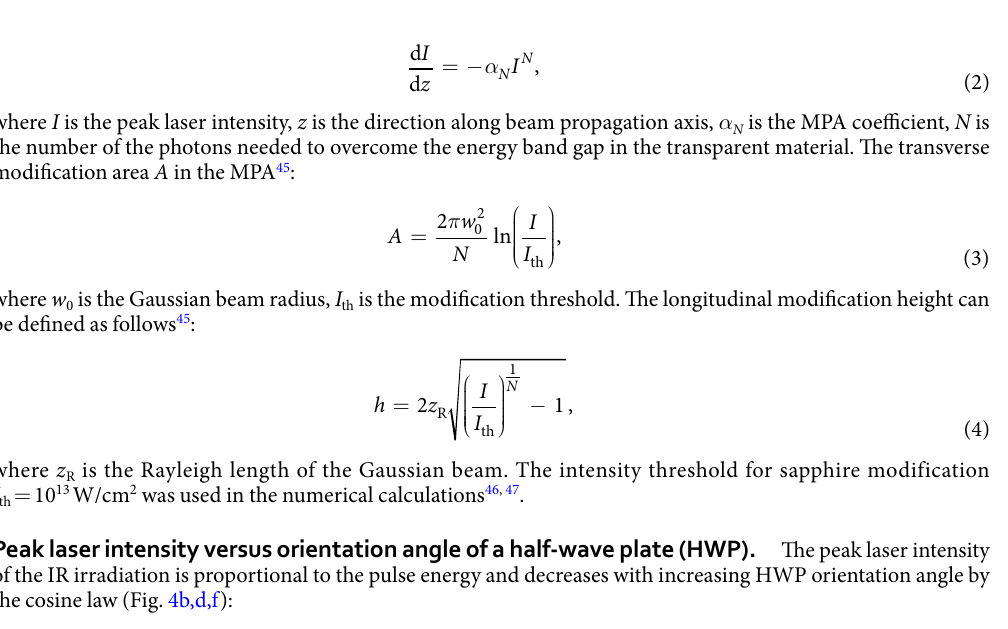
where ϕ - is the angle of HWP orientation with the reference (zero) orientation angle, corresponding to the whole energy directed to the IR optical beam path, E ° 1064 = 20 μ J and E 0 1064 = 68 μ J - is the maximum pulse energy of the fundamental harmonics of the first and second laser sources, respectively. The peak laser intensity of UV irradi- ation is proportional to the pulse energy and increases with the orientation angle of the HWP by sinus function (Fig. 4b,d,f):